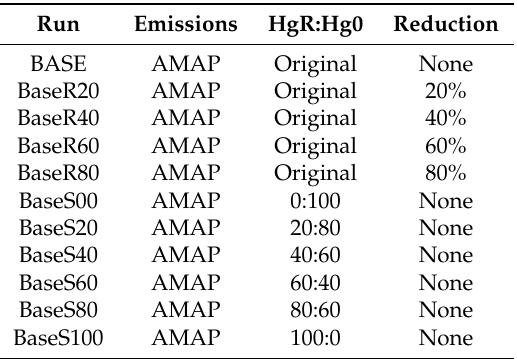
Table 2. List of Scenario experiments conducted with a common emission database (AMAP [21]) and reducing the emissions (BaseR20 to BaseR80) as well as changing the speciation ratio (BaseS00 to